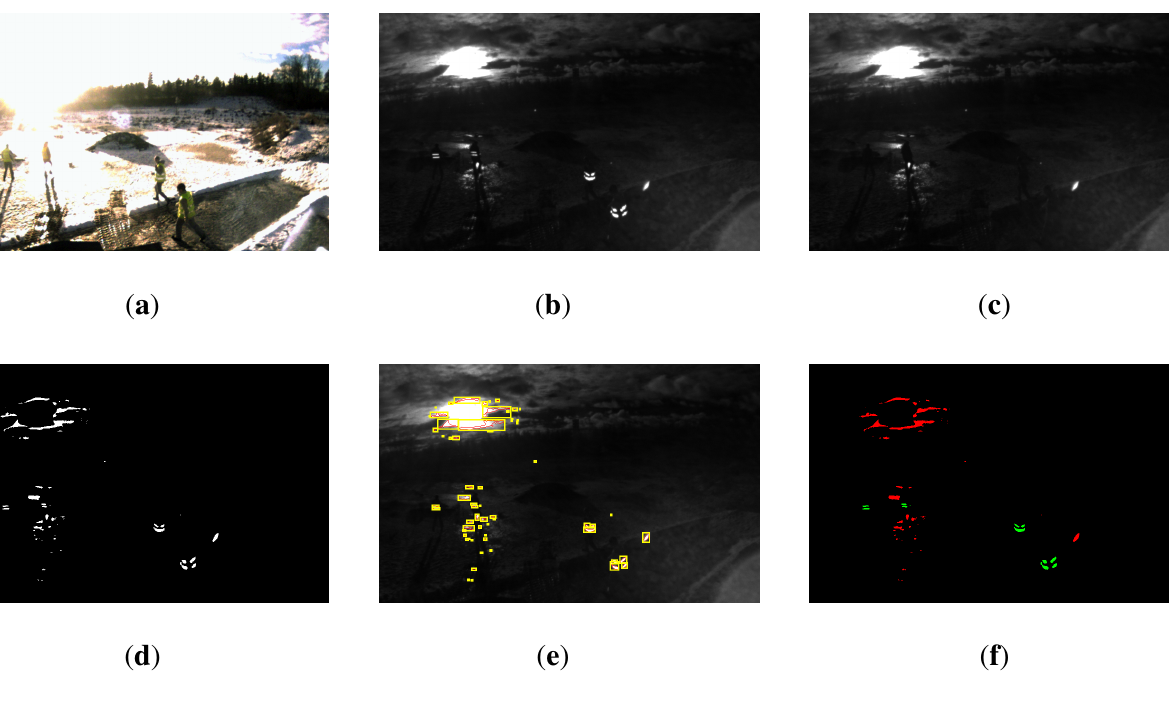
Figure 7. Illustration of the segmentation process for an input image pair acquired in the challenging case of strong backlight conditions. ( a ) Observed scene as captured by a color camera; ( b ) NIR image I captured with flash; ( c ) NIR image I f ( d ) Image I obtained after applying adaptive thresholding to image I s (yellow) around the segmented high-intensity regions. Optical flow based Lucas-Kanade tracking is applied to determine the position of the indicated regions in image I